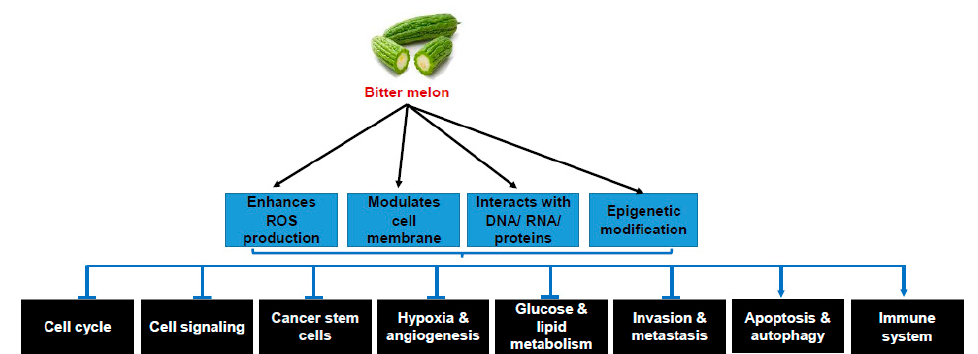
Figure 3. Molecular mechanisms of cancer prevention and therapy by bitter melon. Sharp arrow indicates activation / induction and blunt arrow indicates inhibition.